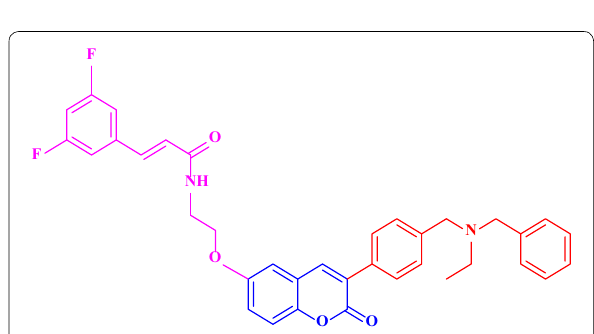
Fig. 73 Molecular structure of compound C87